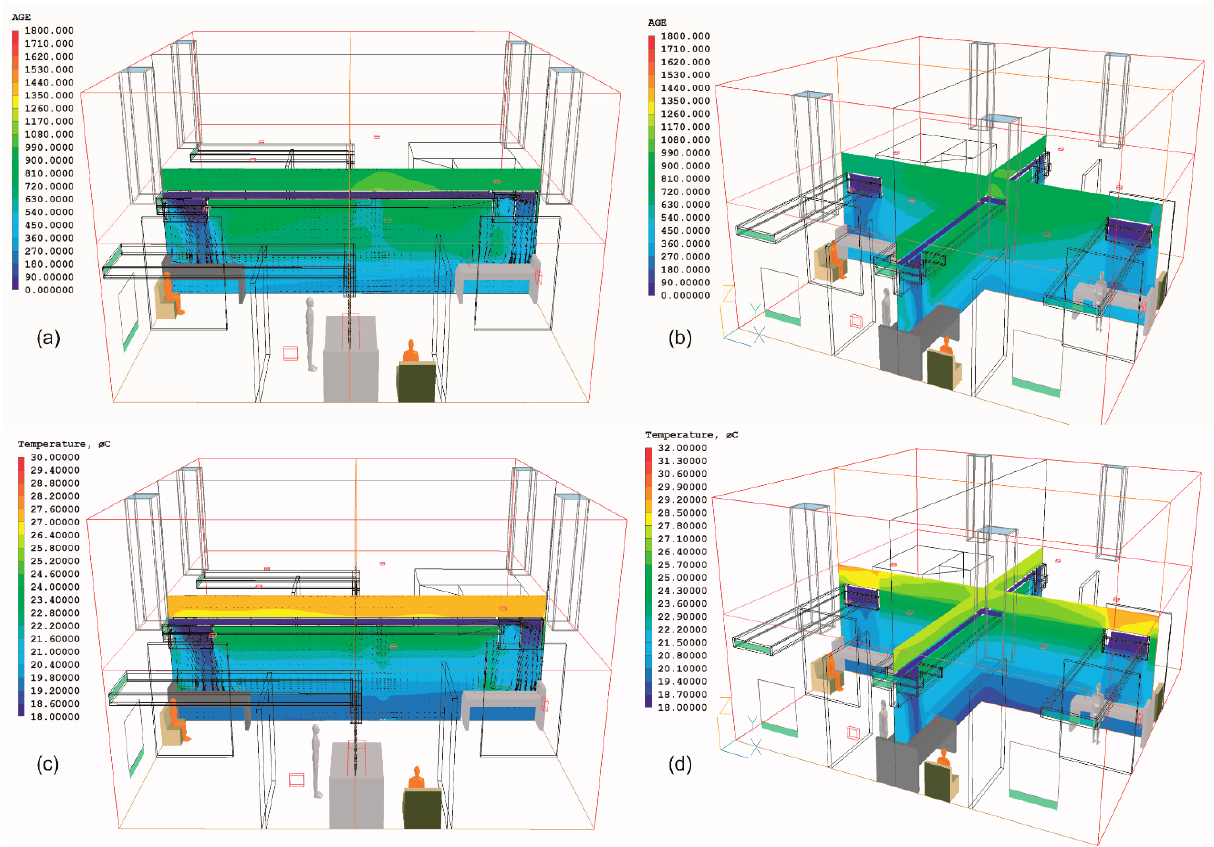
Figure 11. The Cruciform Ward: contours and vectors for age of air shown as: ( a ) Side view; ( b ) Isometric view; and for temperature ( c ) Side view; and ( d ) Isometric